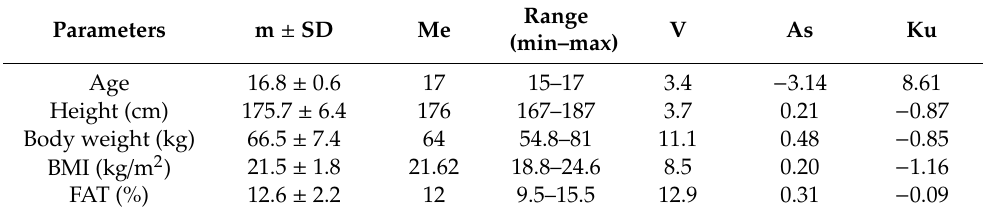
Range V As Ku (min–max)